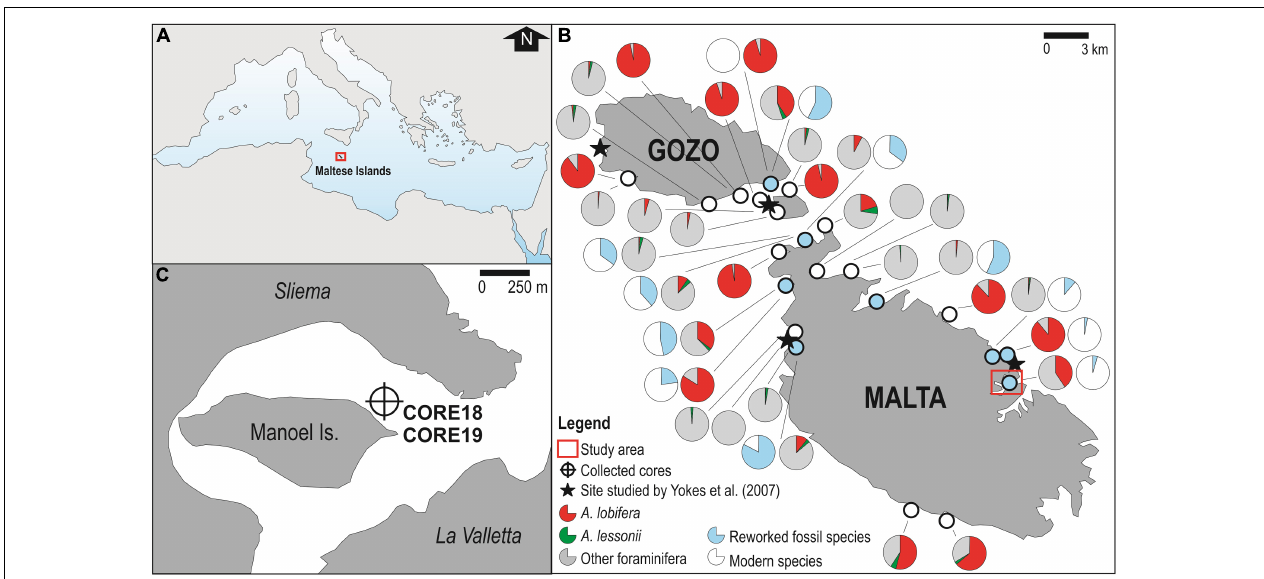
FIGURE 1 | (A) Study area (Central Mediterranean Sea); (B) Current distribution and relative abundance of A. lobifera (in red) and A. lessonii (in green) along the coasts of the Maltese Islands. The pie charts in this panel derived from data available in Guastella et al. (2019) and are supplemented with new data regarding relative abundance of reworked fossil species (in light-blue); (C) Sampling site in Marsamxett Harbor. In the selected site, the relative abundance of A. lobifera and of reworked fossil species are about 40 and 3%, respectively. Additionally, the collection site is close to one site previously studied (Yoke¸s et al., 2007) (black star). Maps derived from Google Earth (https://www.google.it/intl/it/earth/; data providers: Google Landsat/Copernicus Data SIO, NOAA, U.S. Navy, NGA, GEBCO IBCAO) and modified with GIMP v. 2.10.20